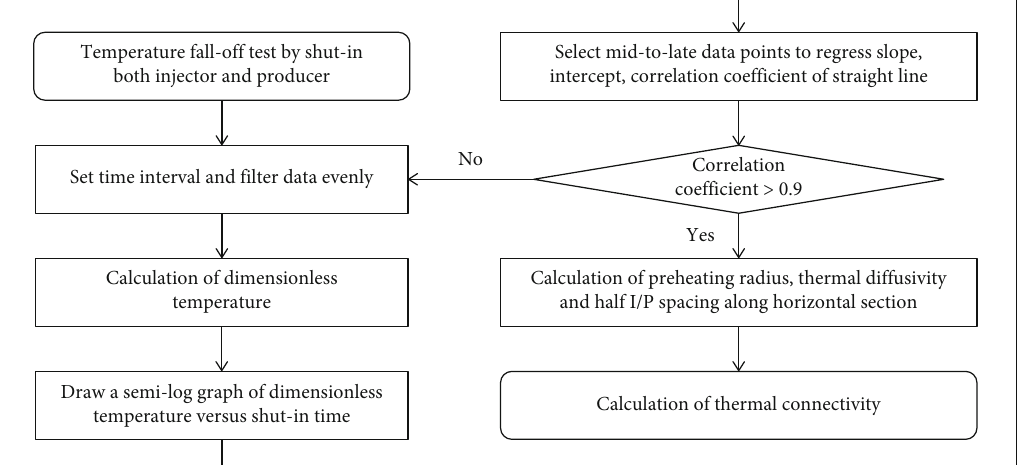
Figure 5: Flow chart of temperature fall-o ff interpretation